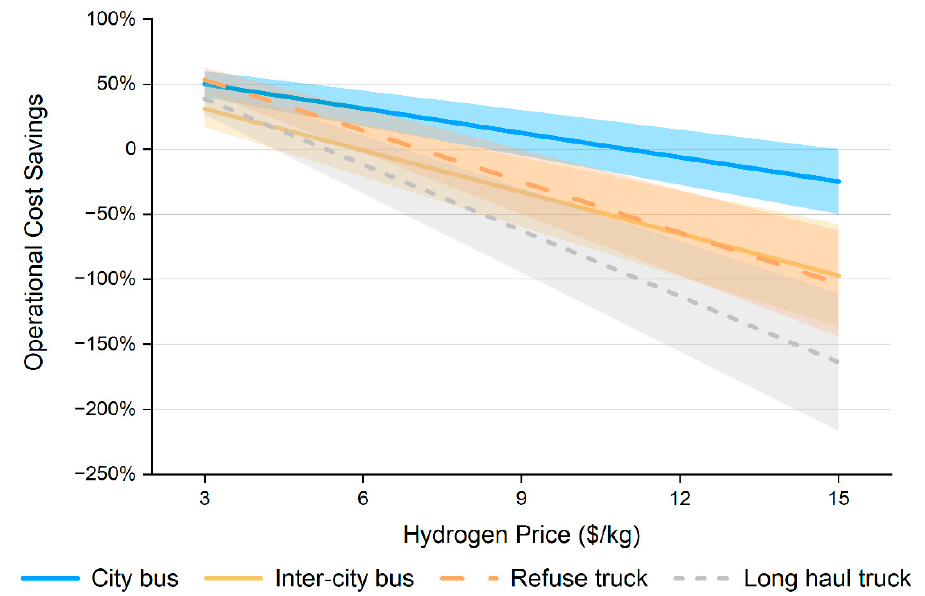
Figure 3. Impact of hydrogen price on operational cost savings of MD/HD fuel cell vehicles in comparison to the diesel versions of these vehicles.